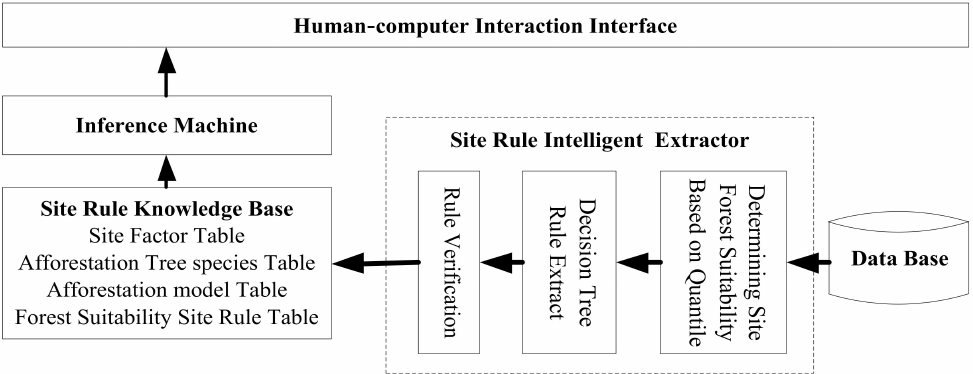
Figure 2. The architecture diagram of the a ff orestation expert assistant decision support